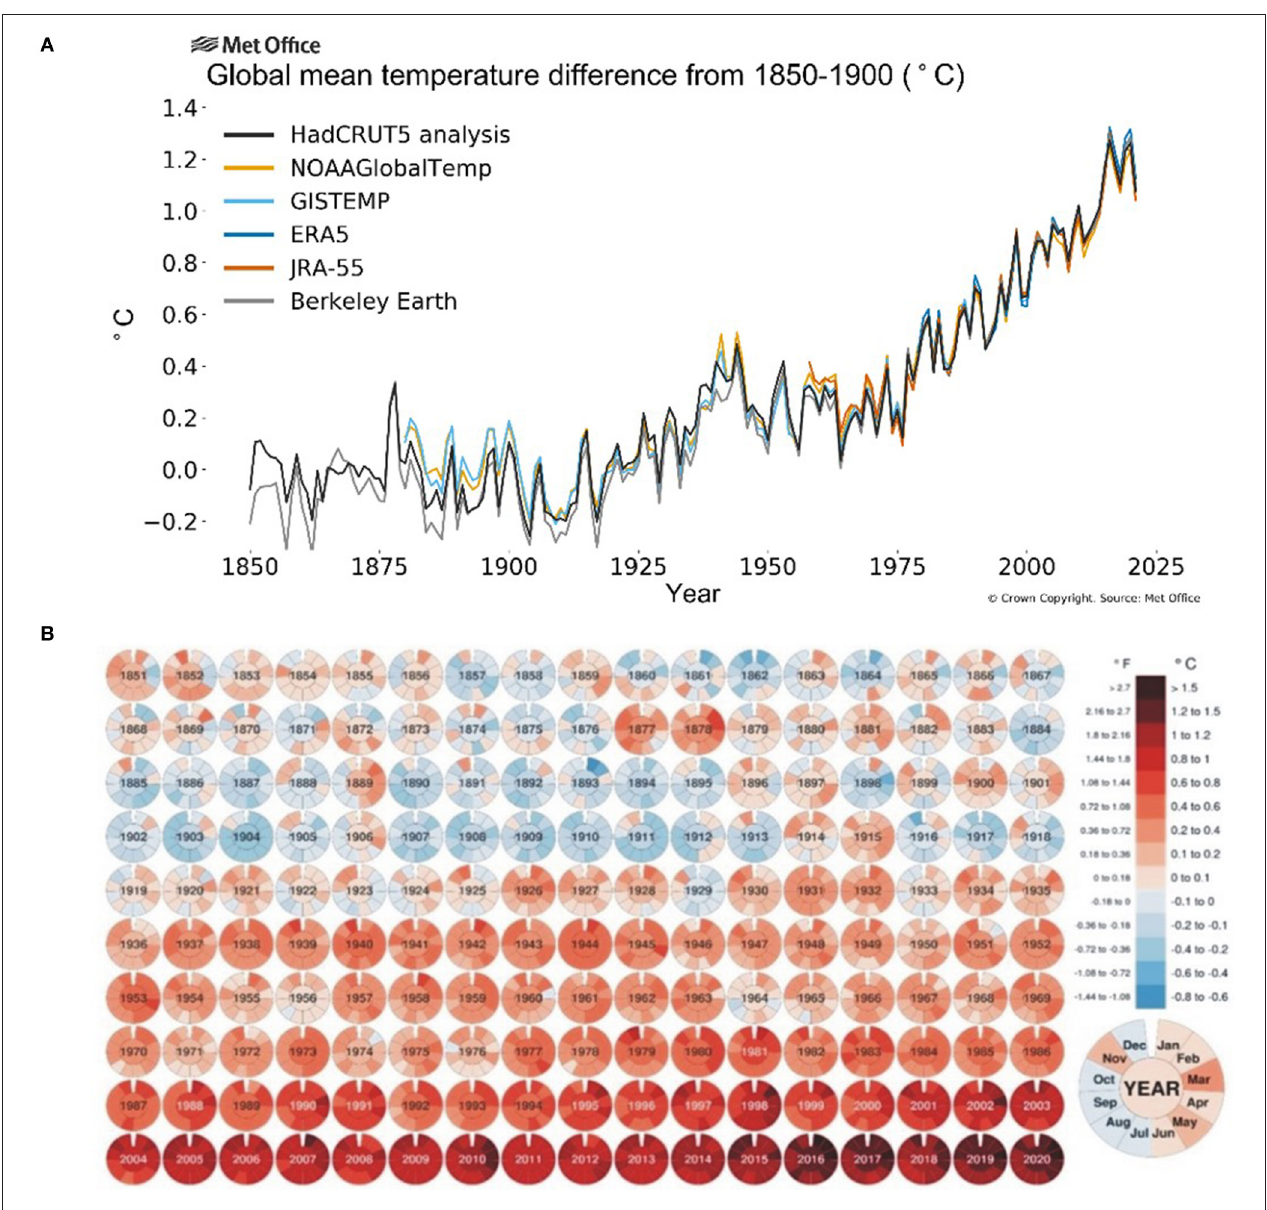
FIGURE 1 | Average global temperatures from 1850 to 2025 compared to a baseline average from 1850 to 1900 (A) source: Berkeley Earth (2019); and monthly global mean temperature 1851–2020 compared to 1850–1900 averages (B) source: Visual Capitalists